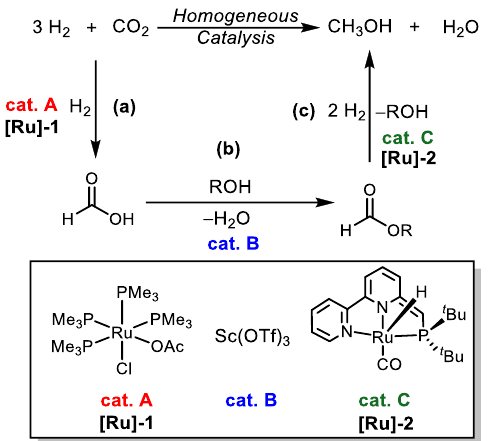
Figure 2. A tandem CO 2 hydrogenation to methanol.